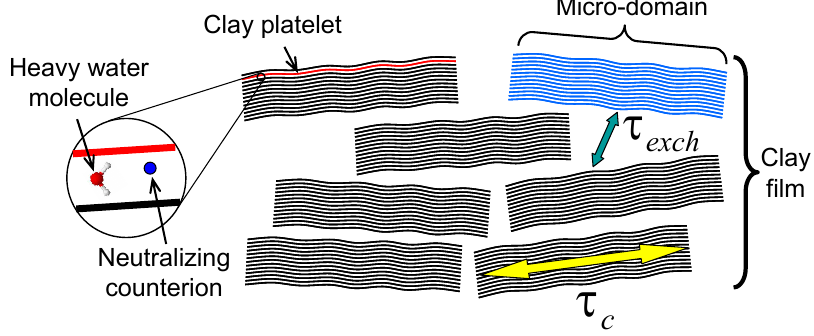
Figure 1. Schematic view of multiscale organization of the clay sediment resulting from the coexistence of clay aggregates with various orientations of the platelet directors. Reprinted with permission from [53]. Copyright (2014) American Chemical